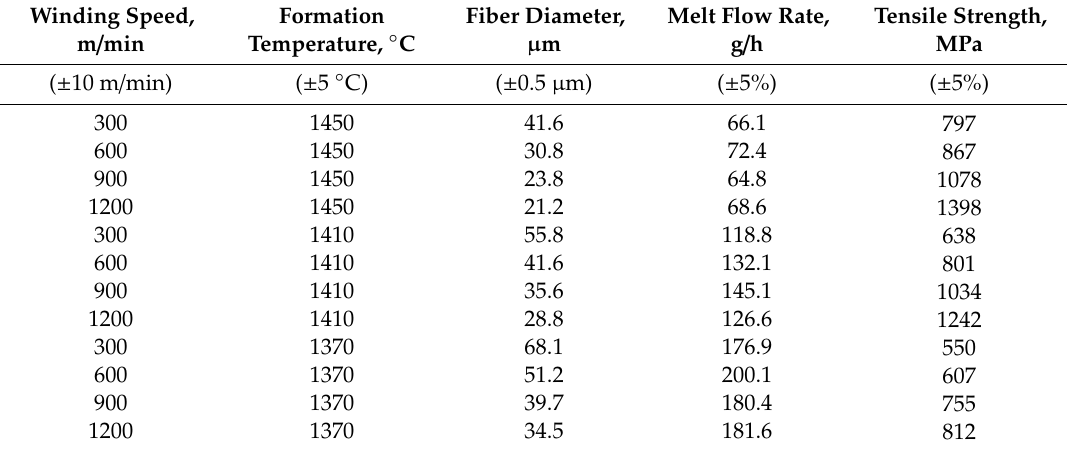
Table 1. Tensile strength of the fibers obtained under di ff erent process parameters using nozzle 1 (diameter 4.5 mm).